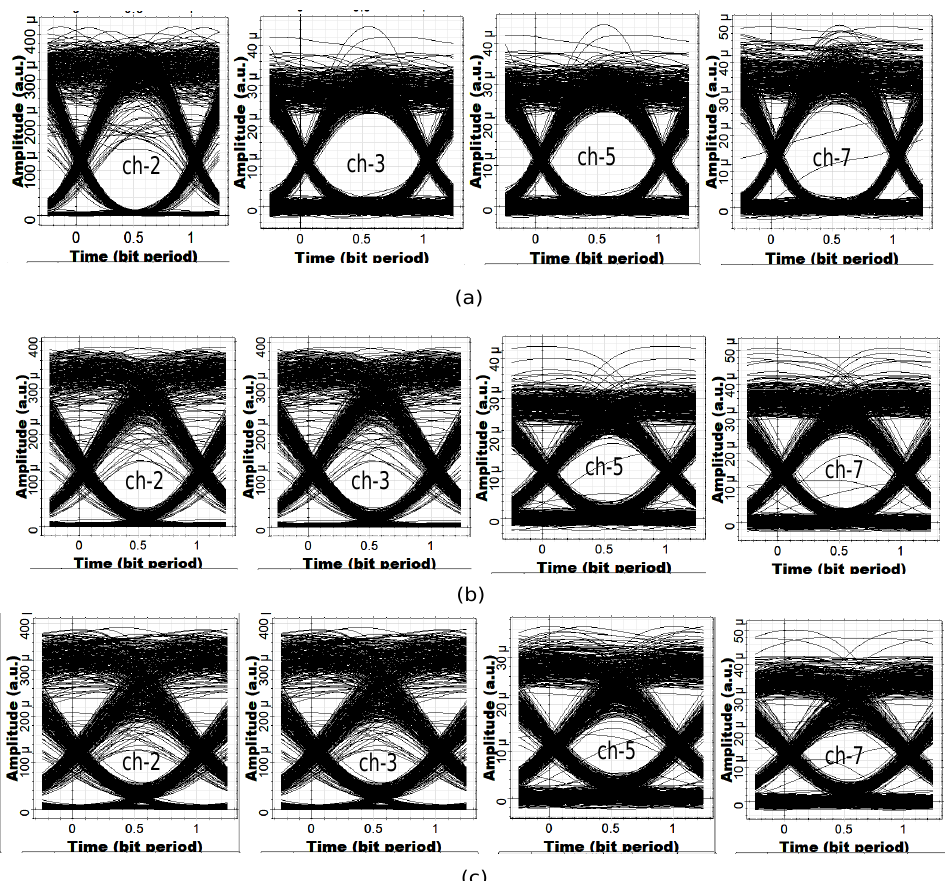
Figure 8. Eye diagrams of channels 2, 3, 5, and 7 at ( a ) 5 Gbps, ( b ) 7.5 Gbps, ( c ) 10